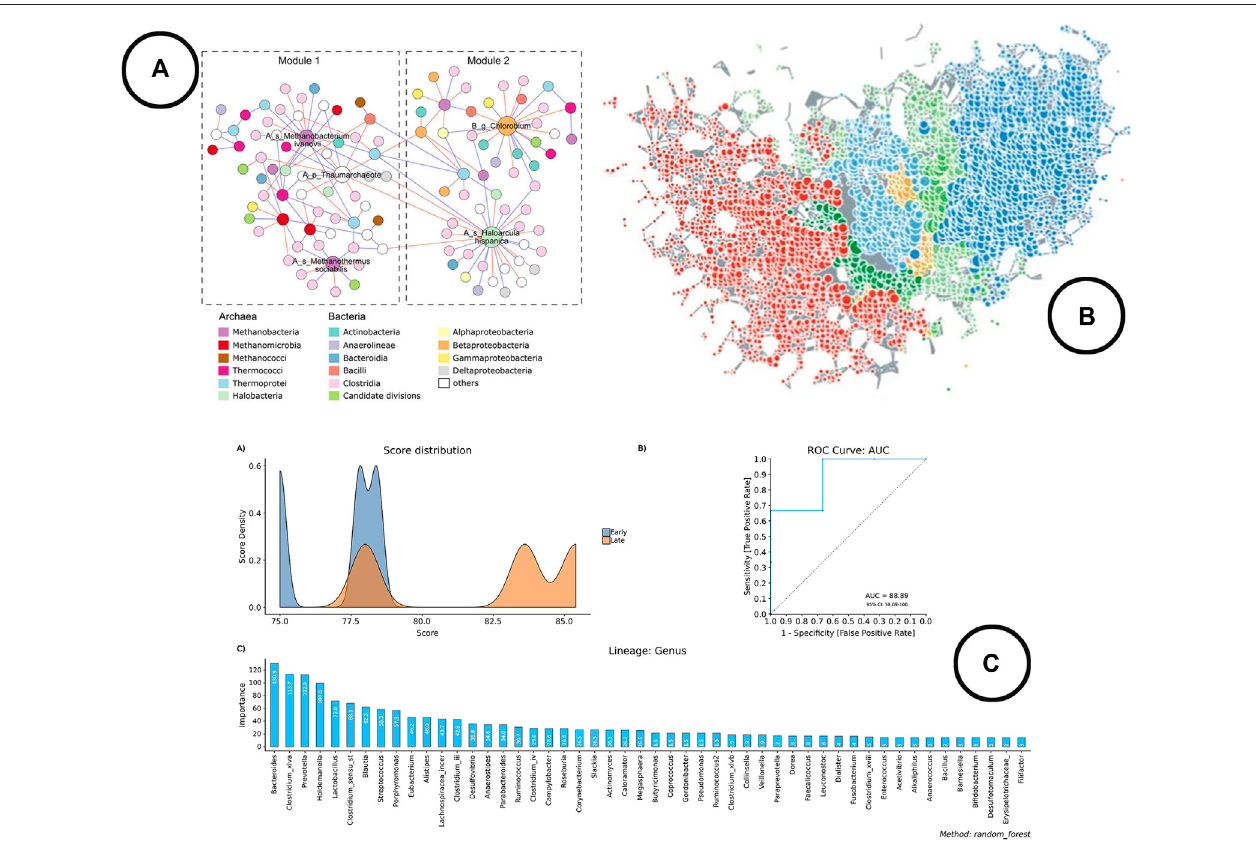
FIGURE6| Anoverviewofthevisualencodingsusedtodisplayclassi fi cationmethodresultsandinteractionsbetweentaxa; (A) taxainteractionnetwork(Wuetal., 2020), (B) taxa interaction network visualized using TDA in TMAP (Liao et al., 2019), (C) visual representation of the results of the Random Forest classi fi er in BiomMiner (Shamsaddini et al.,